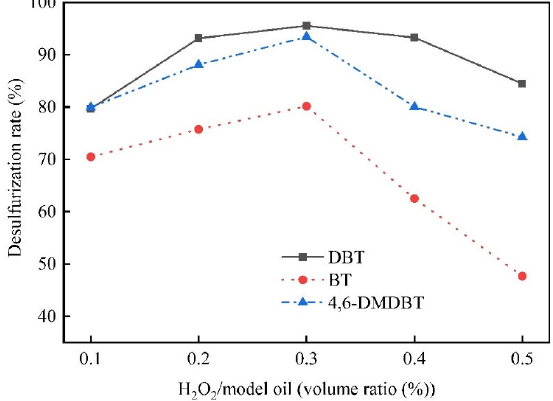
Figure 6. Effect of H 2 O 2 /fuel oil on DBT, BT, and 4,6-DMDBT desulfurization. Reaction conditions for DBT desulfurization: m (catalyst)/ m (fuel oil) = 0.018%, 50 ◦ C, 5 min. Reaction conditions for BT desulfurization: m (catalyst)/ m (fuel oil) = 0.018%, 50 ◦ C, 8 min. Reaction conditions for 4,6-DMDBT desulfurization: m (catalyst)/ m (fuel oil) = 0.018%, 50 ◦ C, 5 min.